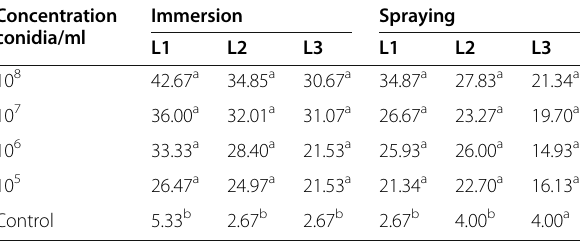
Table 3 Mortality percent of Xanthogaleruca luteola larvae by Metarhizium anisopliae using immersion and spraying methods Concentration